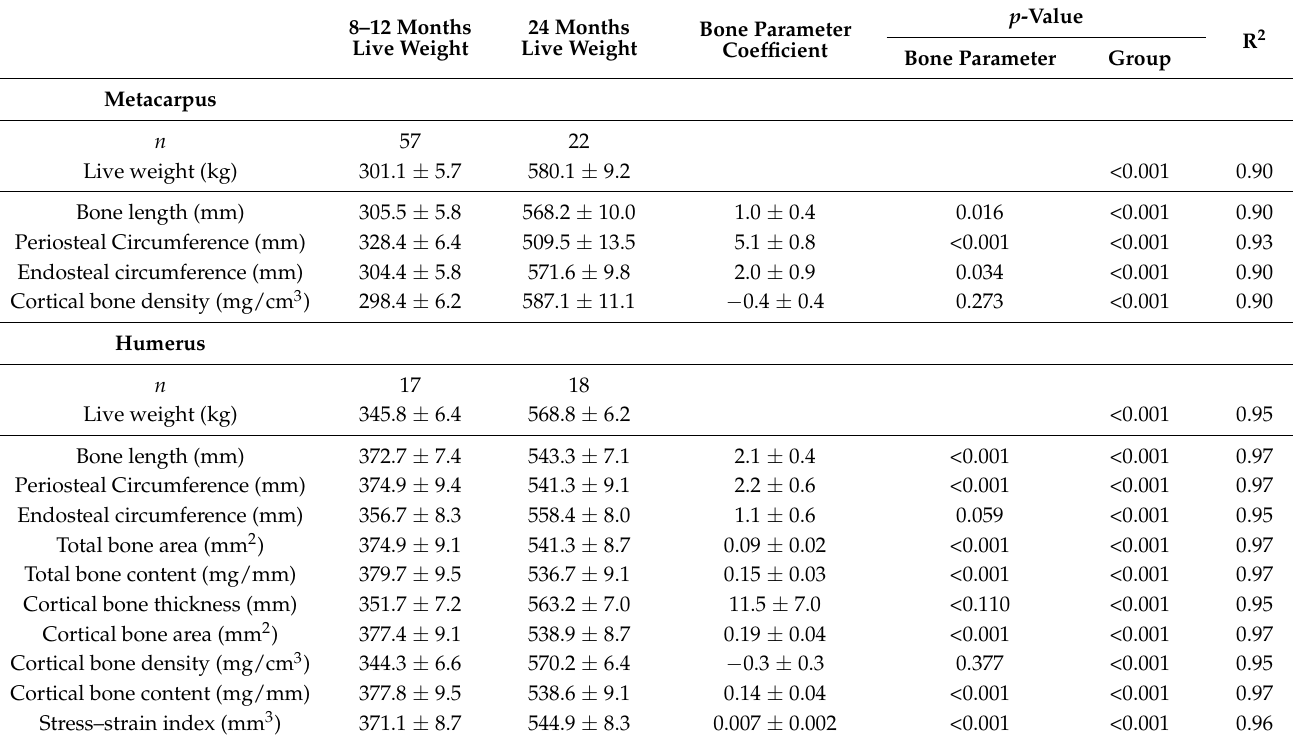
Table 3. Live weight adjusted for each bone parameter in the metacarpus and humerus of control steers (8–12 months) and 24-month-old steers from cohort three for which there was no interaction of bone parameter and group. Values are the least squared mean ( ± standard error) live weight for each age group adjusted to the overall mean value of the bone parameter identified in that